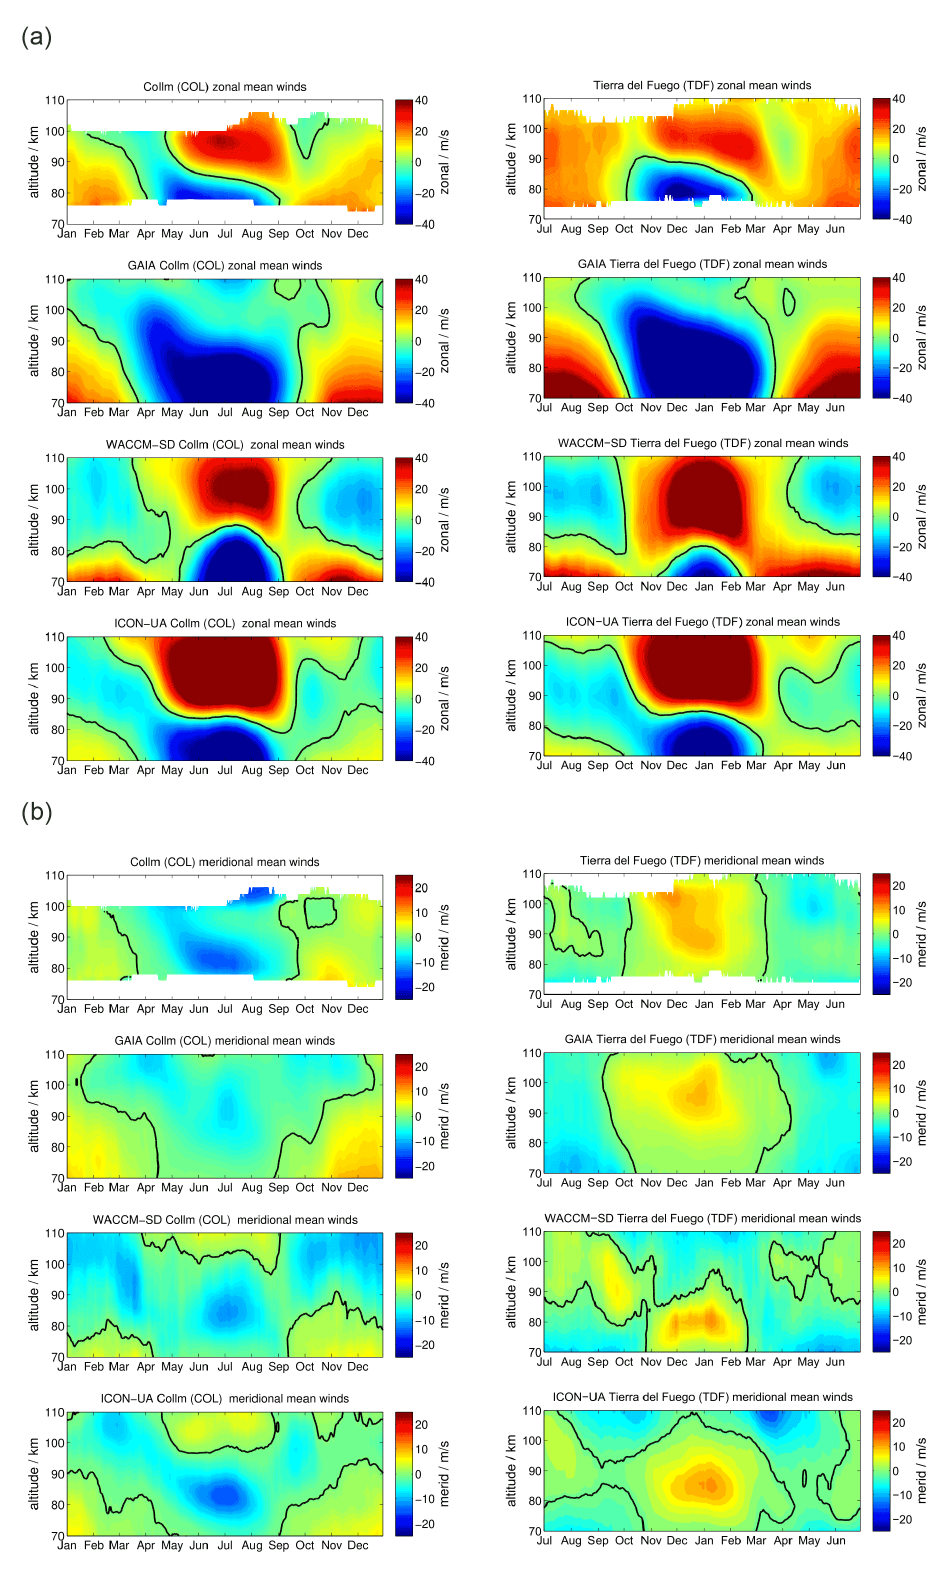
Figure 9. The same as Fig. 2, but for the midlatitudes at COL and TDF.